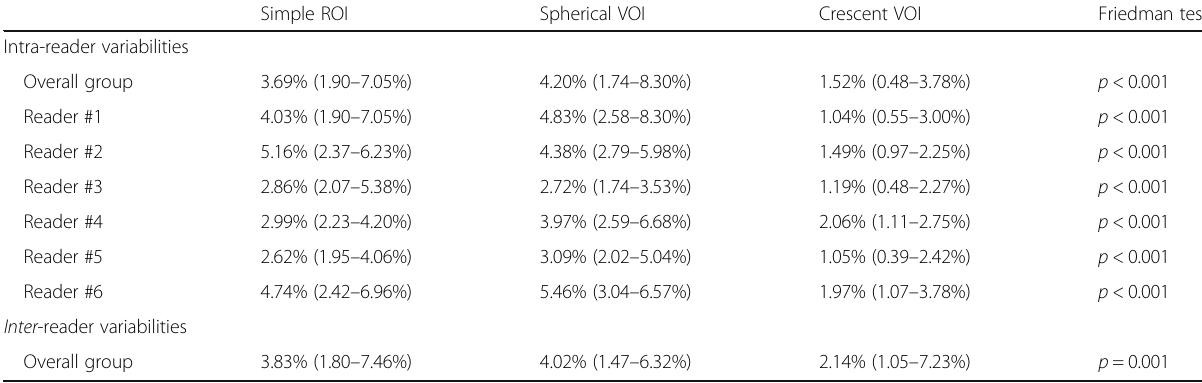
Table 1 Intra- and inter-reader coefficients of variation using VOI/ROIs [median (range)] Simple ROI Spherical VOI Crescent VOI